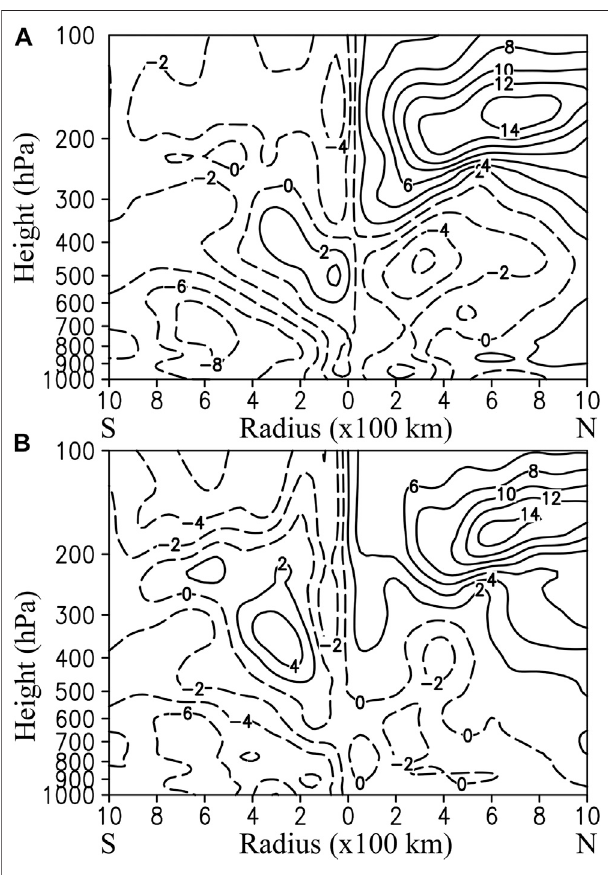
FIGURE 10 | Vertical cross-section of the magnitude of in fl ows (m s − 1 , dashed) and out fl ows (m s − 1 , solid) associated with the synoptic-scale circulation from south to north at (A) 1800 UTC Sep 17, 2006 and (B) 0600 UTC Sep 18,